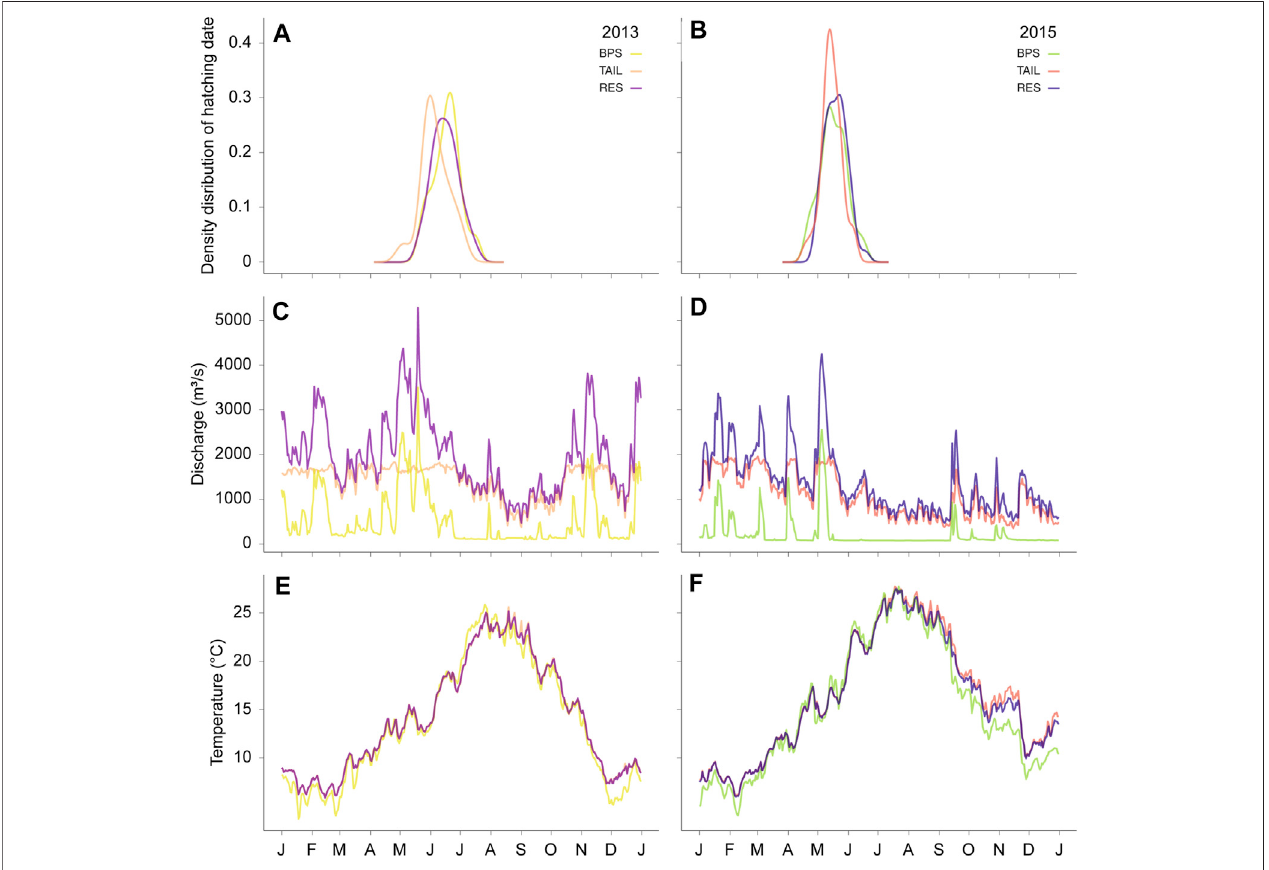
FIGURE 3 | Hatching date distributions (A , B) , daily mean discharges (m 3 s − 1 ) (C , D) , and daily mean water temperature ( ° C) patterns (E , F) during the two studied years (2013, left panels and 2015, right panels ).